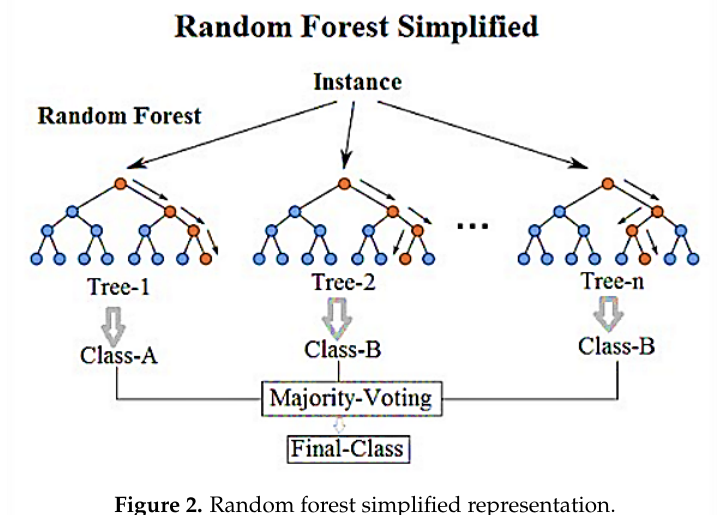
Figure 2. Random forest simplified